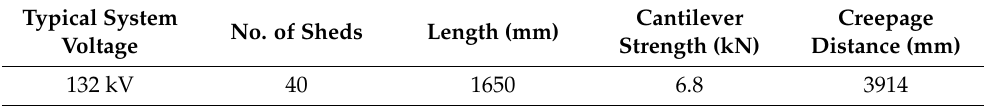
Figure 1. 2D geometry model of non-ceramic insulator and corona ring. Table 1. Dimensions of insulator string for 132 kV system voltage.